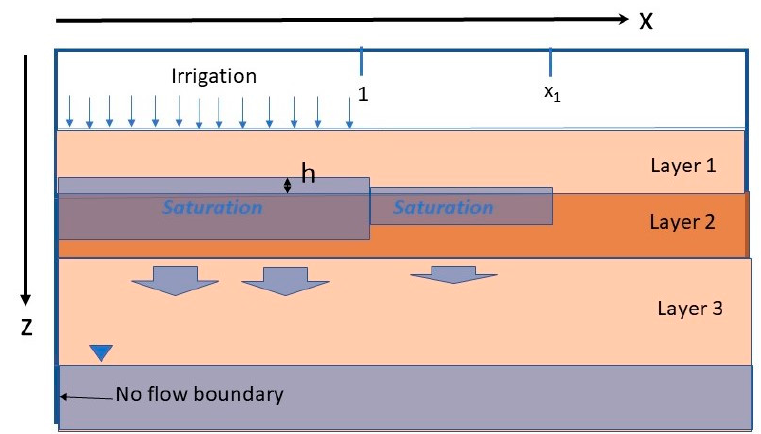
Figure 2. Used to simulate recharge under perched water tables. The left-hand boundary is a no flow boundary, representing a line of symmetry. The variables are non-dimensionalised, with x = 1 being the outer limit of irrigation and x = x 1 being the outer limit of perched water. Below layer 3 is the saturated zone of the aquifer.